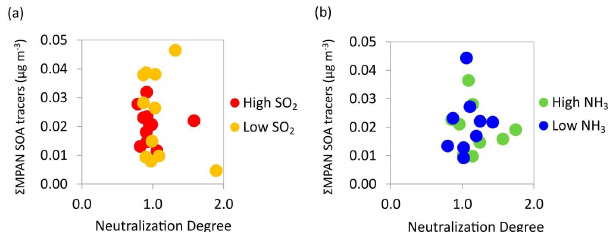
Fig. 11. Effects of aerosol acidity on isoprene high-NOx SOA for- Figure 11. Effects of aerosol acidity on isoprene high-NO x SOA formation: (a) SO 2 conditional 704 mation: (a) SO 2 conditional samples; (b) NH 3 conditional samples. samples (b) NH 3 conditional samples. No clear associations between aerosol acidity and the sum 705 No clear associations between aerosol acidity and the sum of MAE- derived SOA tracers were observed for either SO 2 or NH 3 condi- of MAE-derived SOA tracers were observed for either SO 2 or NH 3 conditional samples. 706 tional